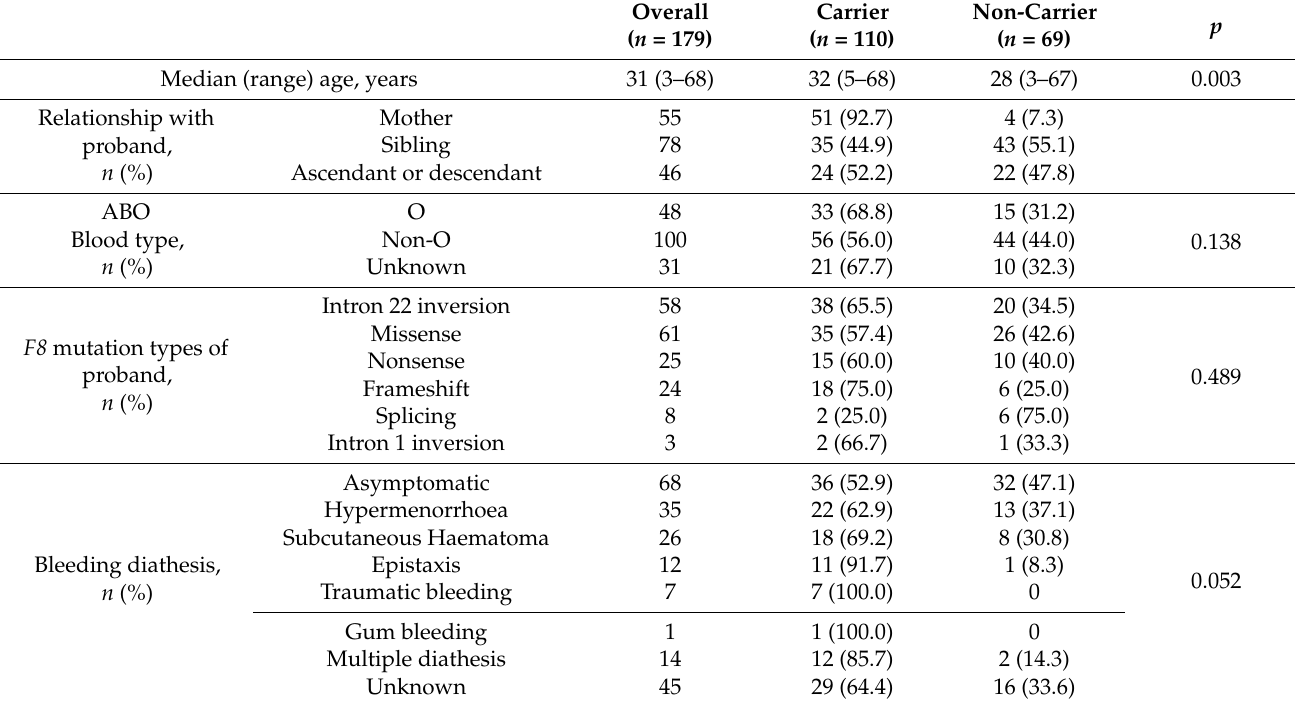
Table 1. Characteristics of subjected